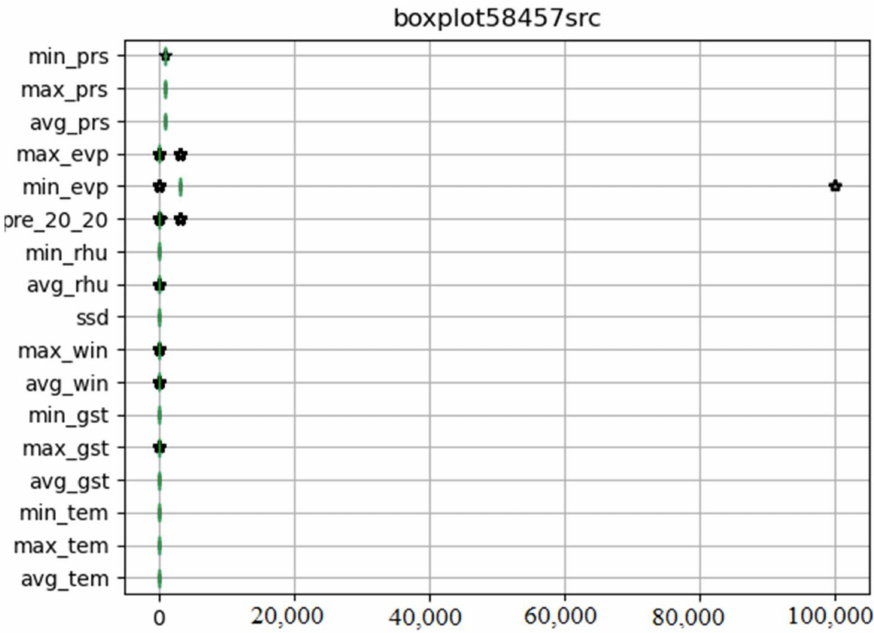
Figure 2. Illustration of the original meteorological data with abnormal